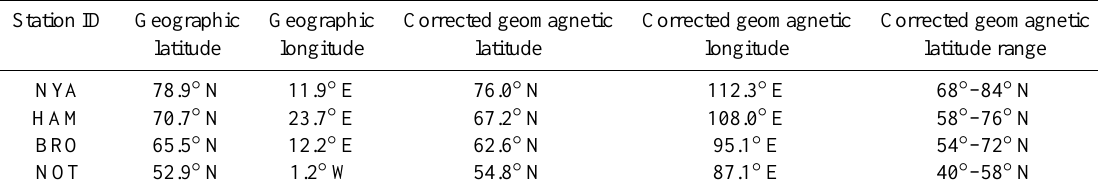
Table 1. Geographic and corrected geomagnetic coordinates together with the magnetic latitude range of the field of view of the GISTM receiver sites at 350km.